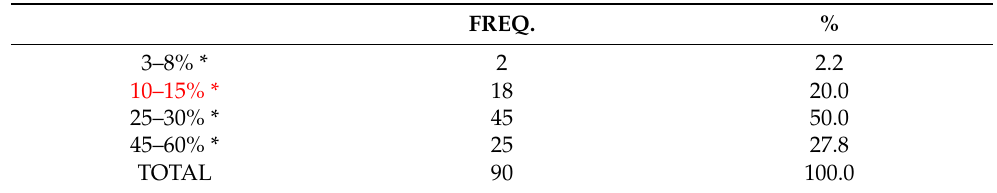
Table 2. Percentage of responses about the global prevalence of periodontal disease (correct answer red colour).